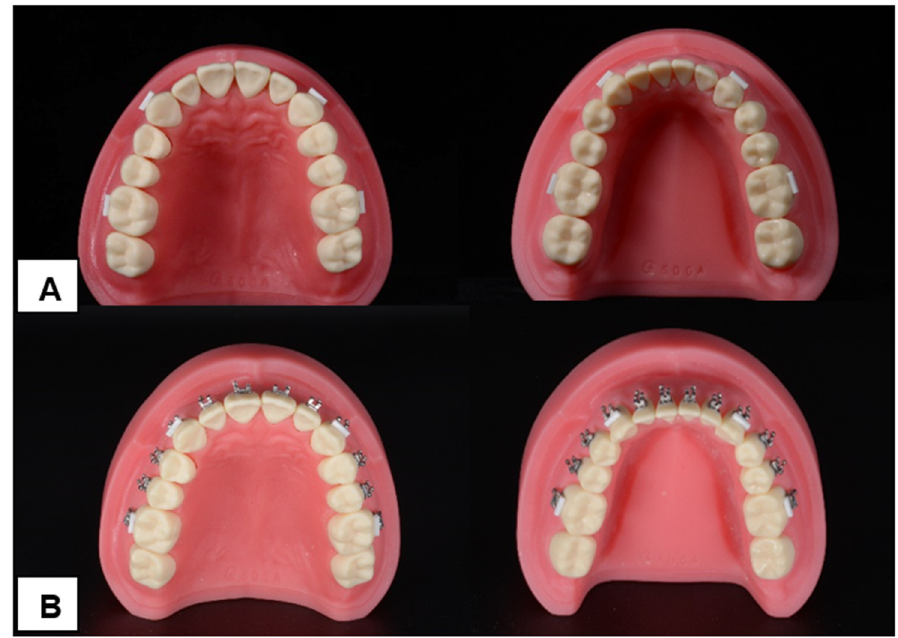
Figure 2. Pictures of customized dental models: ( A ) models without orthodontic brackets; upper arch and lower arch models, ( B ) models with orthodontic brackets; upper arch and lower arch models.